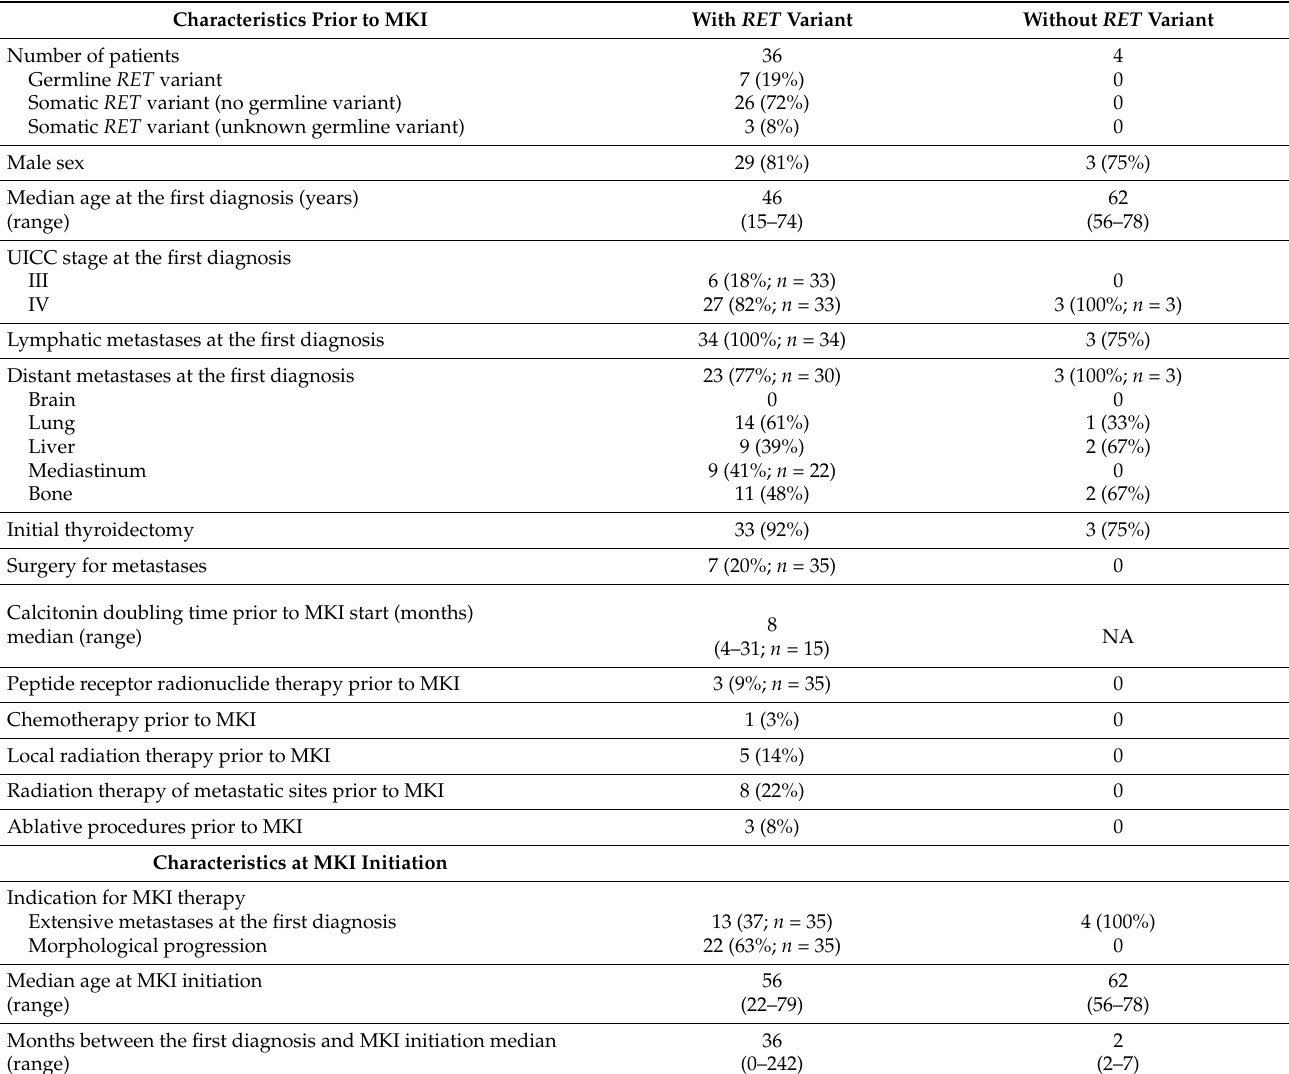
Table A2. Characteristics of patients with cabozaninib/vandetanib as first-line